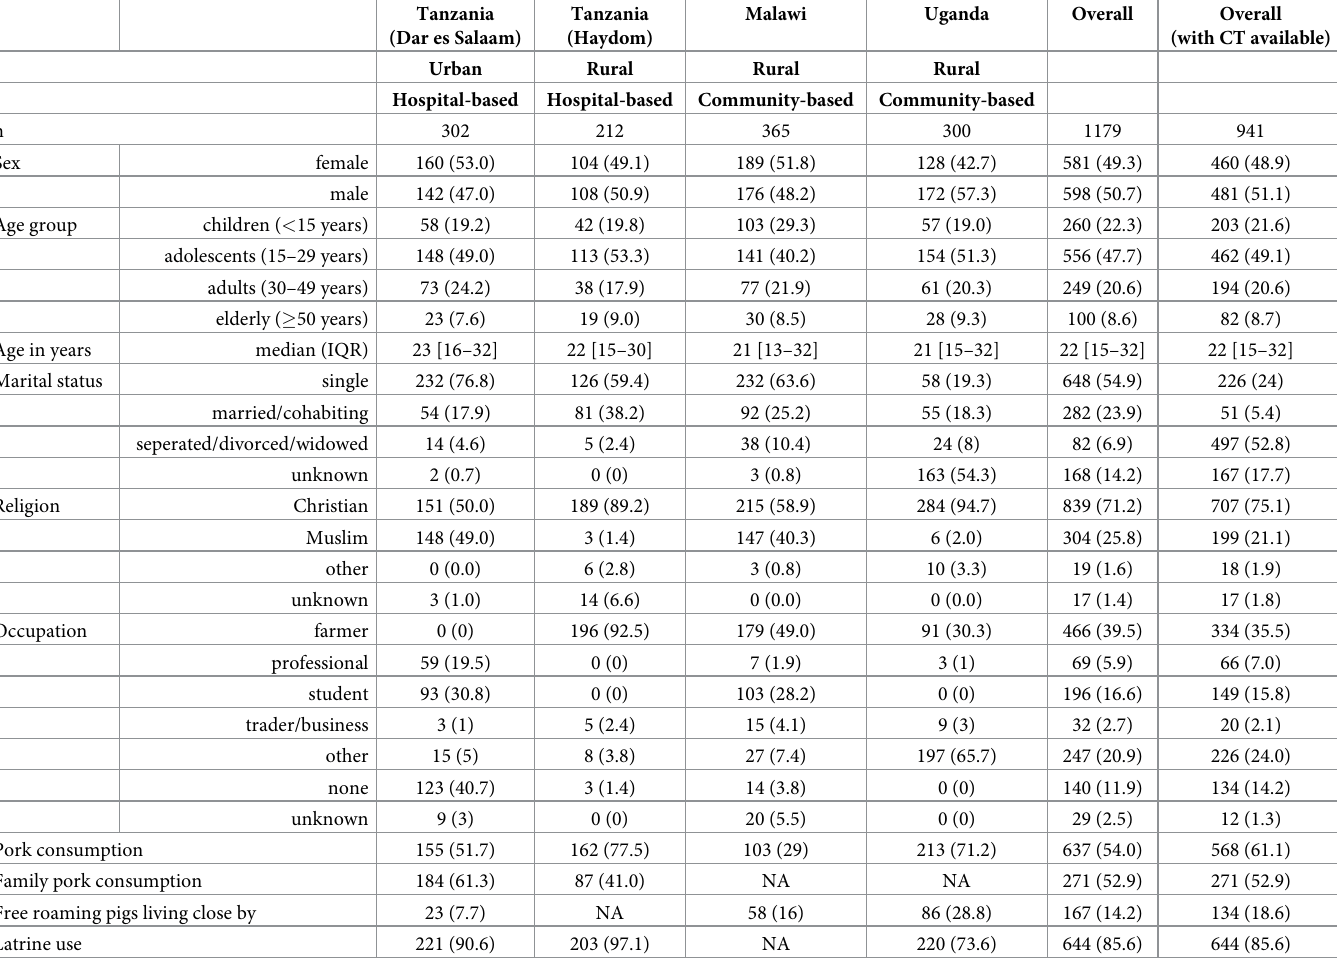
Table 1. Baseline characteristics of people with epilepsy from four different studies.